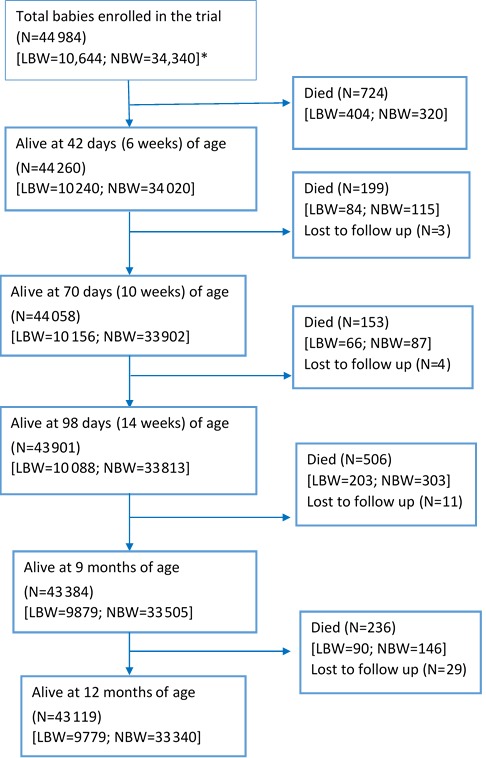
Flow of infants recruited in the primary trial. *LBW – low birth weight; NBW – normal birth weight. The flow shows the number of alive babies at 6, 10, 14 weeks and at 9 and 12 months of age specifically with the intention of present the number of babies eligible for OPV1/DPT1 (given at 6 weeks), OPV2/DPT2 (given at 10 weeks), OPV3/DPT3 (given at 14 weeks) and Measles (given at 9 months of age).